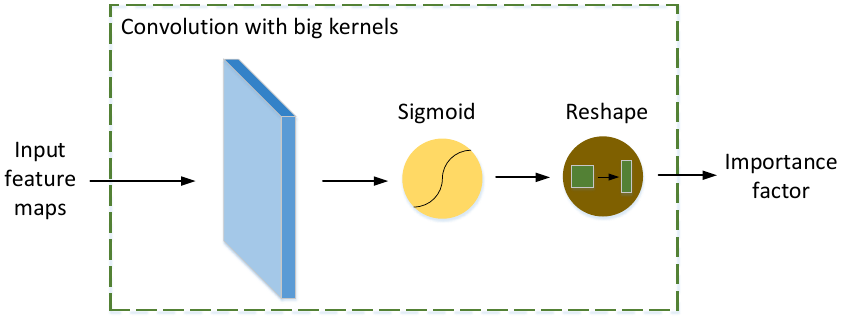
Figure 4. The importance factor